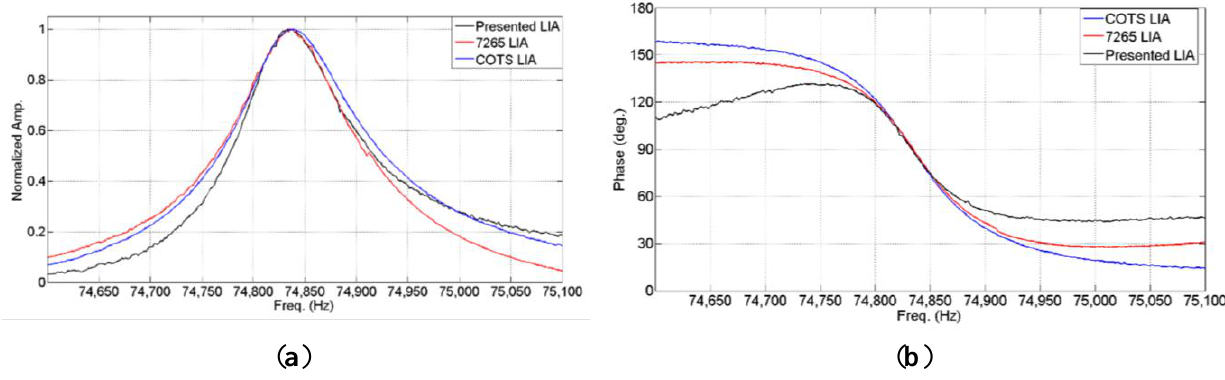
Figure 14. Normalized amplitude ( a ) and phase ( b ) values obtained for a frequency sweep around fundamental frequency of a microcantilever using three different recovery devices using a frequency step of 1 Hz.